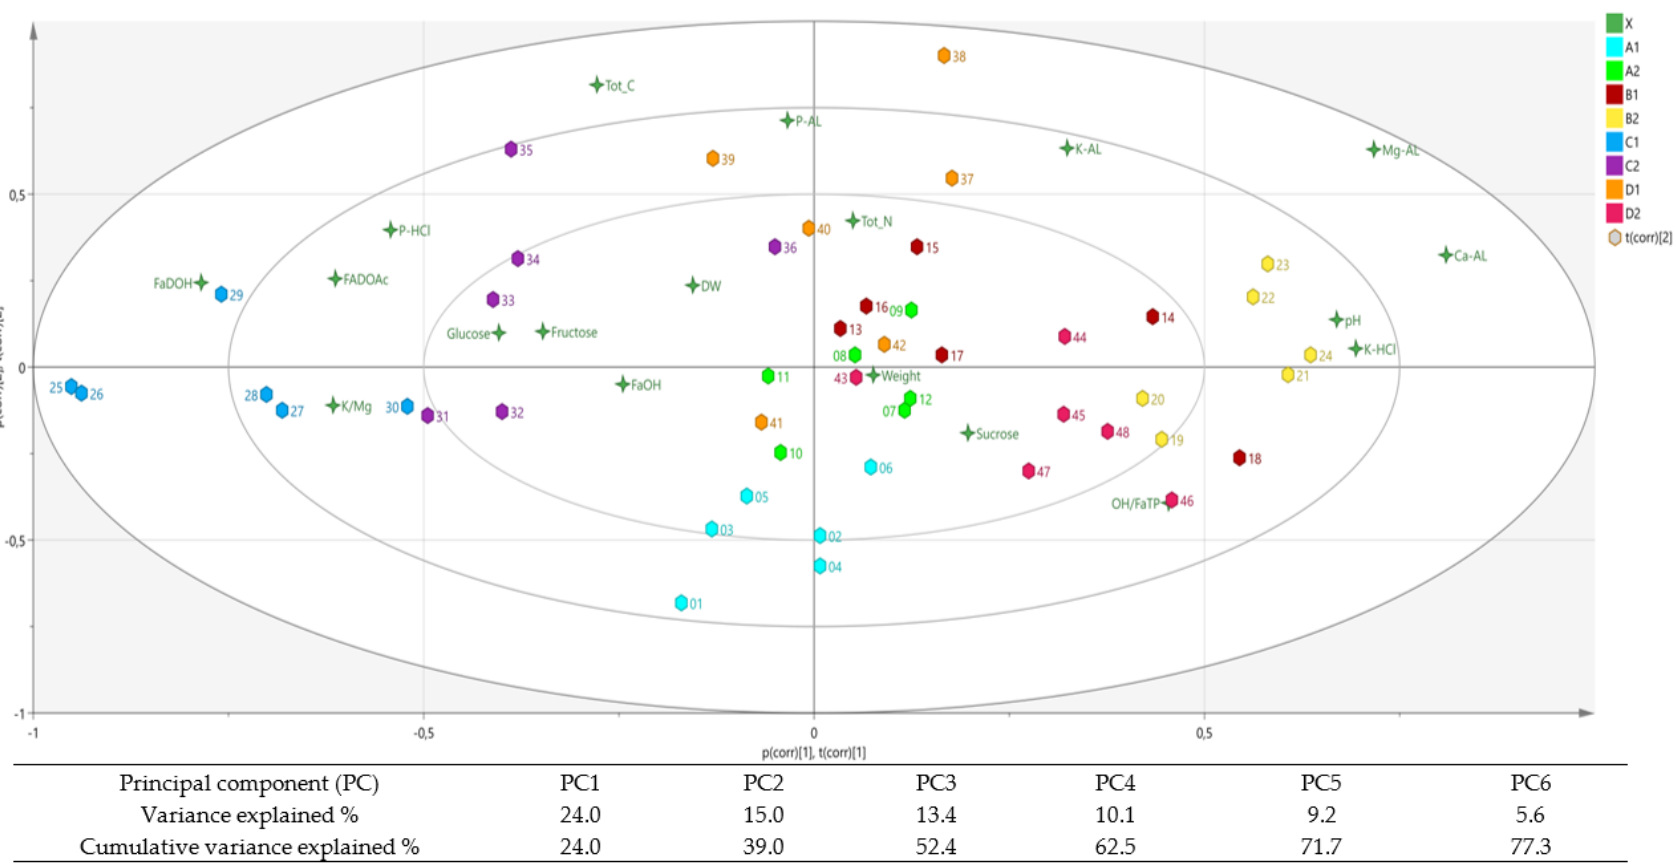
Figure 2. Biplot from principal component analysis (PCA) of soil and carrot variables at harvest on 10 September 2006. Diagram shows principal component (PC) scores for PC1 and PC2. Colours indicate variables and sectors of blocks in the field trial, numbers indicate plot number in the field trial (see Figure 1). Insert: Table of explained variance values for PCs 1–6.